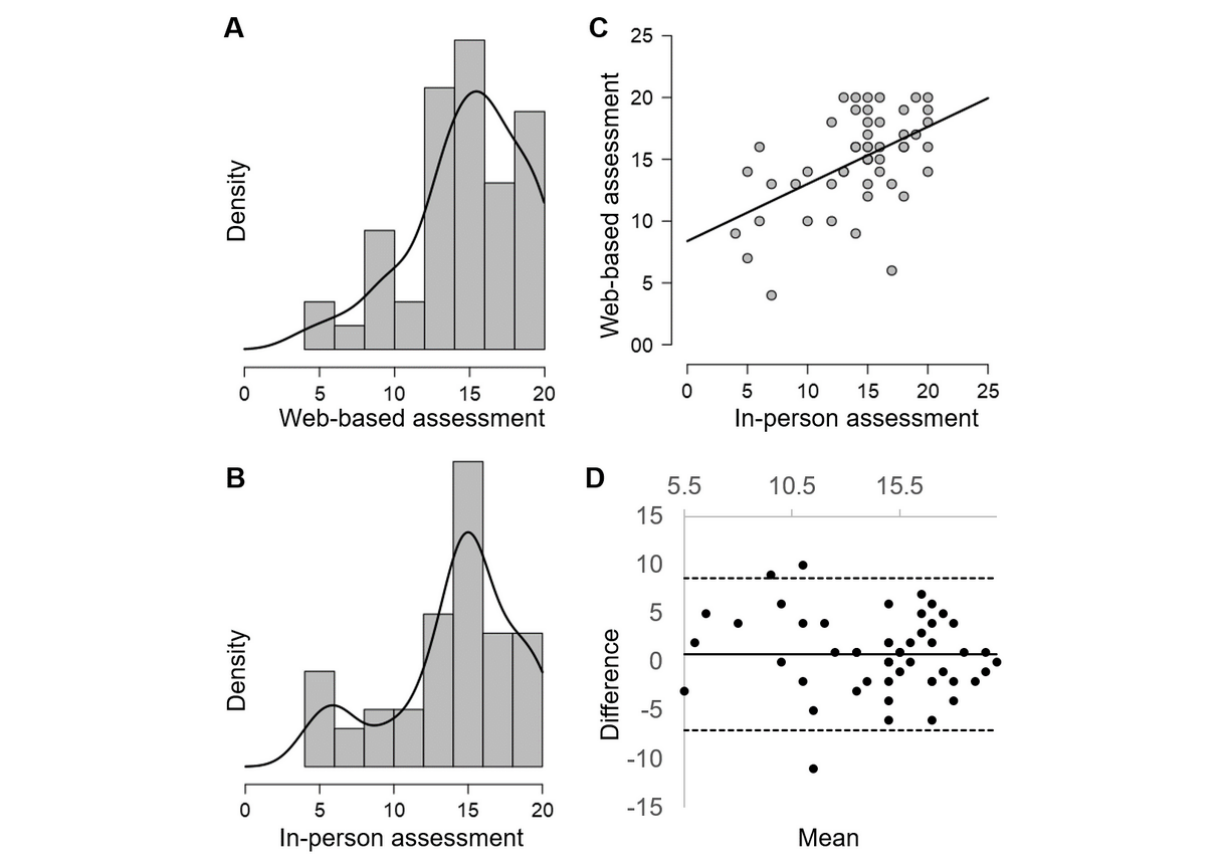
Figure 3. Comparison of Paired Associate Learning First Attempt Memory Score across test settings. Density plot for (A) web-based assessment and (B) in-person assessment showing similar distributions; (C) scatterplot with reference line showing linear relationship between assessment settings ( ρ =0.45); (D) Bland-Altman plot: mean difference (solid black line) is close to zero, showing no bias; dashed lines delimit limits of agreement. Proportional bias is seen: greater differences at lower mean measurements and 94% of data within limits of